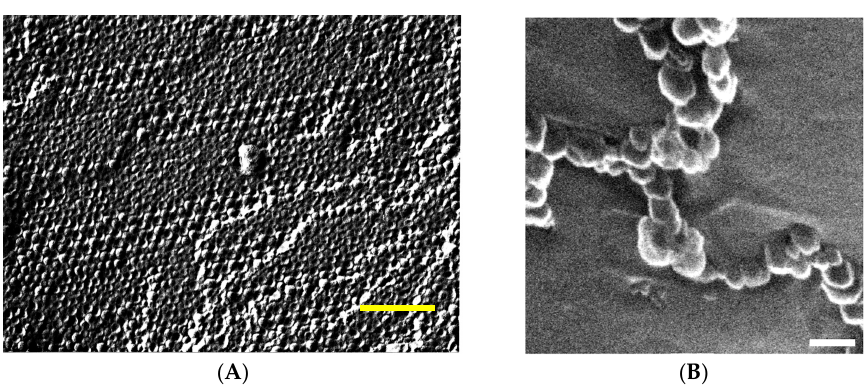
Figure 3. ( A ) Freeze-fracture transmission electron microscopy (FF-TEM) image of densely packed ULV in the system 182 Na isostearate/567 mM 1-octanol (the aqueous solution contained 20 wt % glycrol to facilitate the FF preparation (size bar: 200 nm) [41]; ( B ) cryo scanning electron microscopy (cryo-SEM) image of a C 18 –C 8 gemini vesicle gel (size bar: 66.7 nm) [46].